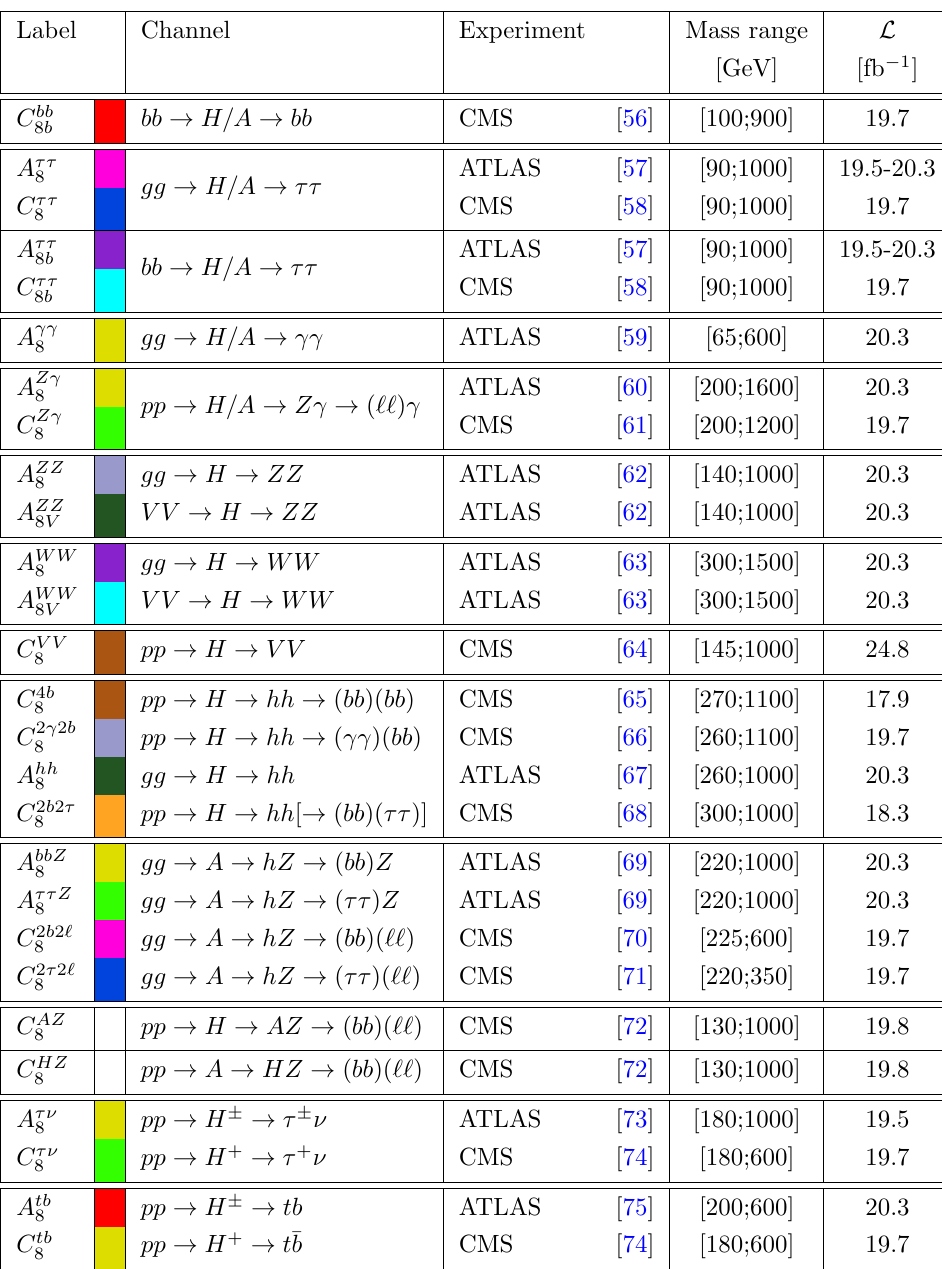
Table 5 . List of the available heavy Higgs searches from LHC Run 1 relevant for the 2HDM. In the (cid:12)rst column, we assign a label and colour to each search, which correspond to the ones in (cid:12)gures 6 to 12. Details of production and decay modes are given in the second column. The third column contains the corresponding reference. The mass ranges, for which the corresponding limits on (cid:27) (cid:1) B are given, and the integrated luminosity the searches are based on, can be found in the fourth and (cid:12)fth column. The CMS Run 1 limits of the di-photon channel are included in their Run 2 bounds. V V refers to either WW or ZZ . C V V